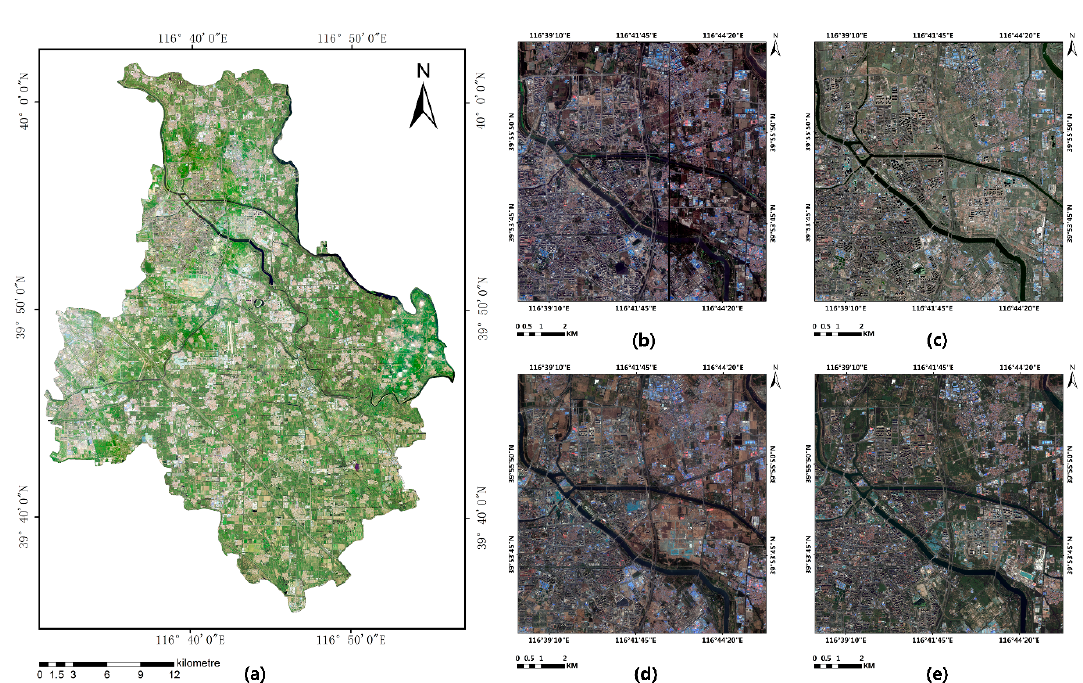
Figure 2. ( a ) Experiment data, ( b ) Worldview-3 HSRRSI data of September 2017, ( c ) Worldview-3 HSRRSI data of October 2014, ( d ) GF-2 HSRRSI data of April 2016 and ( e ) GF-2 HSRRSI data of September 2018.